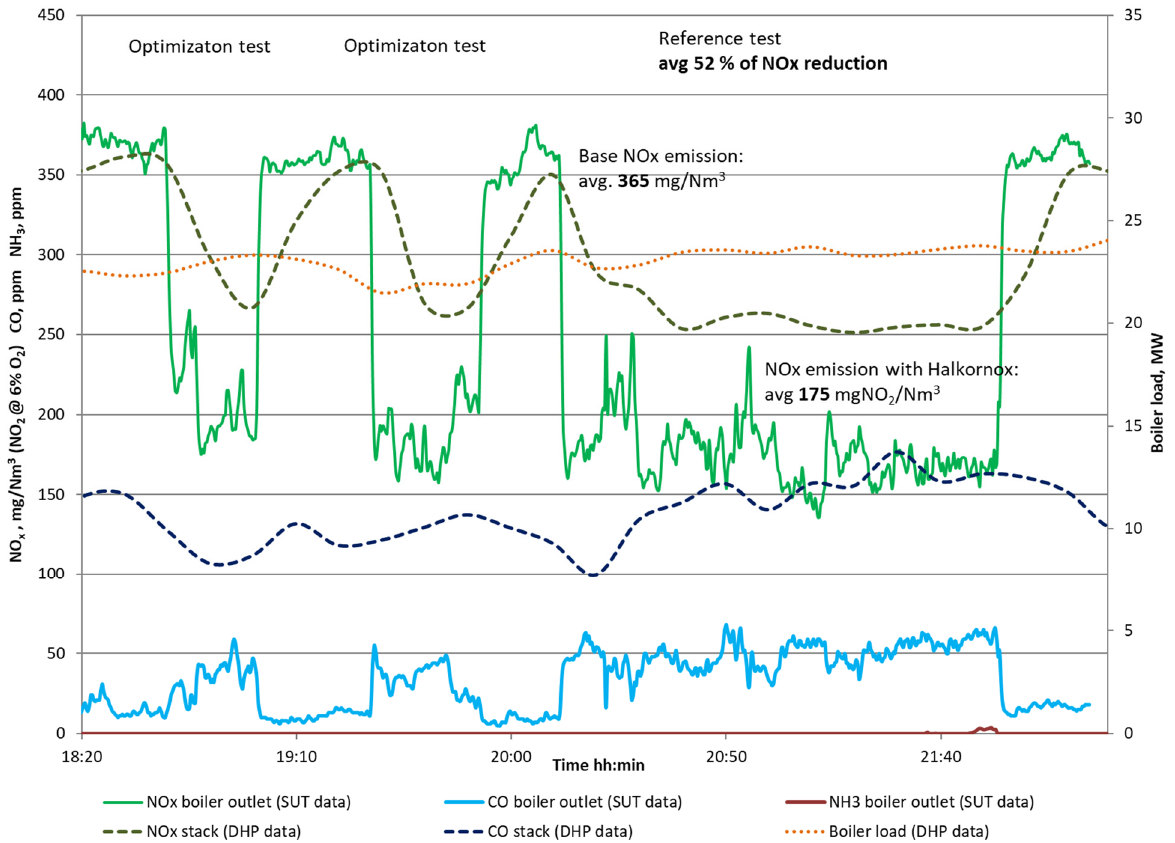
Figure 6. NO x , CO and NH 3 emissions during HALKORNOKS tests measured by SUT and DHP equipment. The two optimization tests allow adjusting the installation before the reference